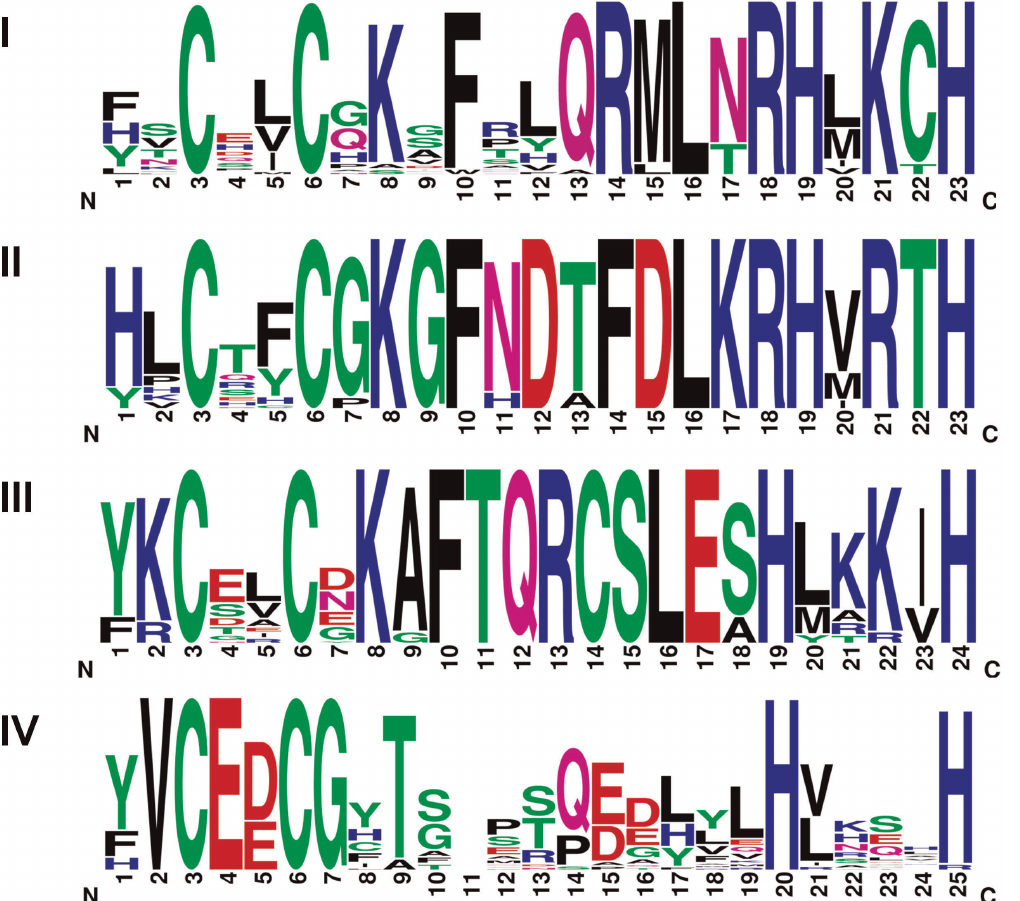
Figure 6. Sequence logo of four different Cys2-His2 (C2H2) zinc finger motifs (I-IV) present in different OVOL proteins from metazoan genomes. We generated this sequence logo using WebLogo 3.0 [81]. C2H2 zinc finger motif IV has 25 amino acids due to the presence of one extra amino acid at the eleventh position in the OVOLNVE1 protein from sea anemone. doi:10.1371/journal.pone.0039399.g006 PLoS ONE |